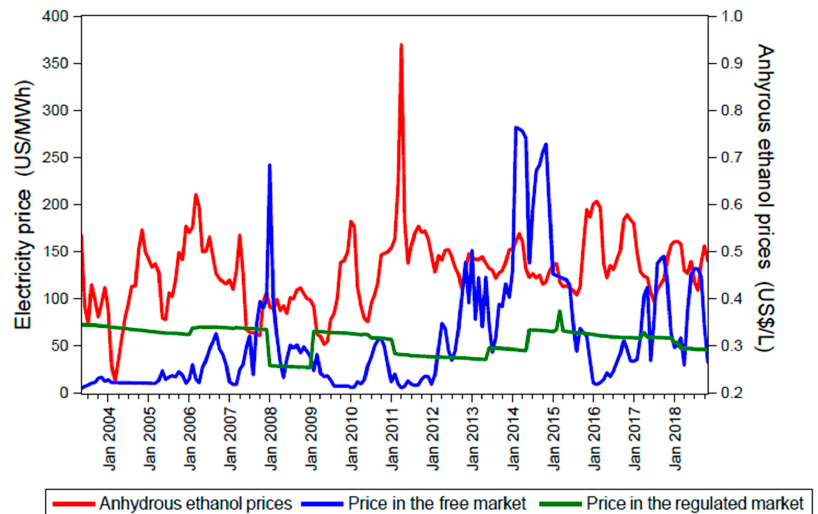
Figure 2. Historical data of the market prices for anhydrous ethanol and electricity in Brazil. Source: Own elaboration based on the data obtained from [24] and [26].